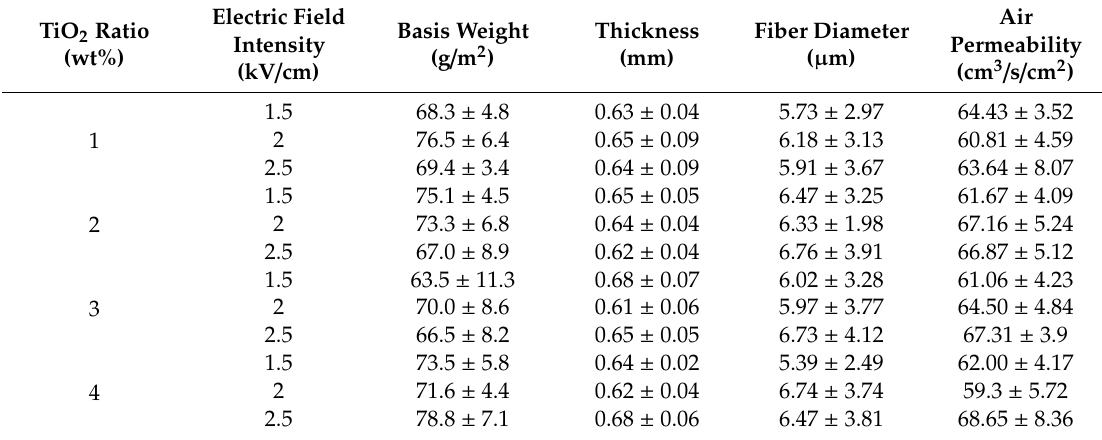
Table 1. Intrinsic properties of samples made of di ff erent parameters.